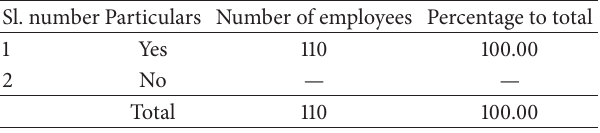
Table 10: Solve the problem of the account holders. Sl. number Particulars Number of employees Percentage to